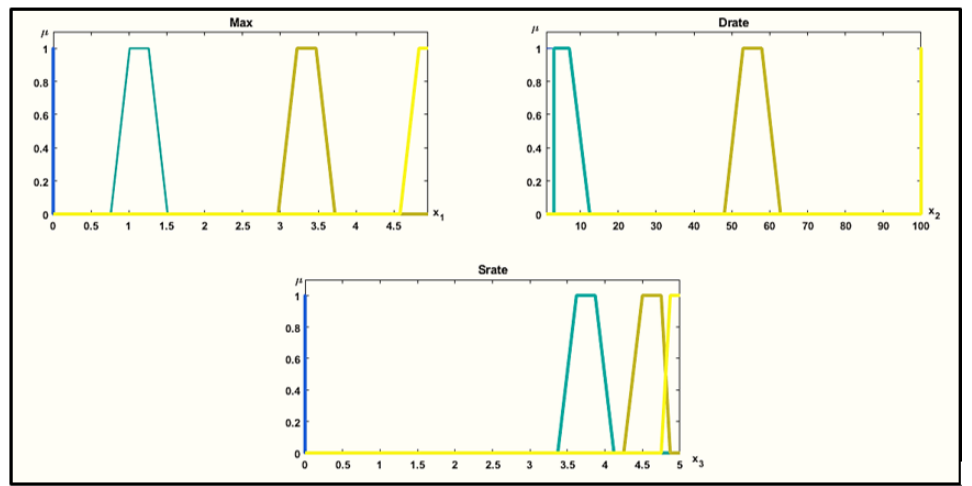
Figure 2. The Optimized Fuzzy Sets